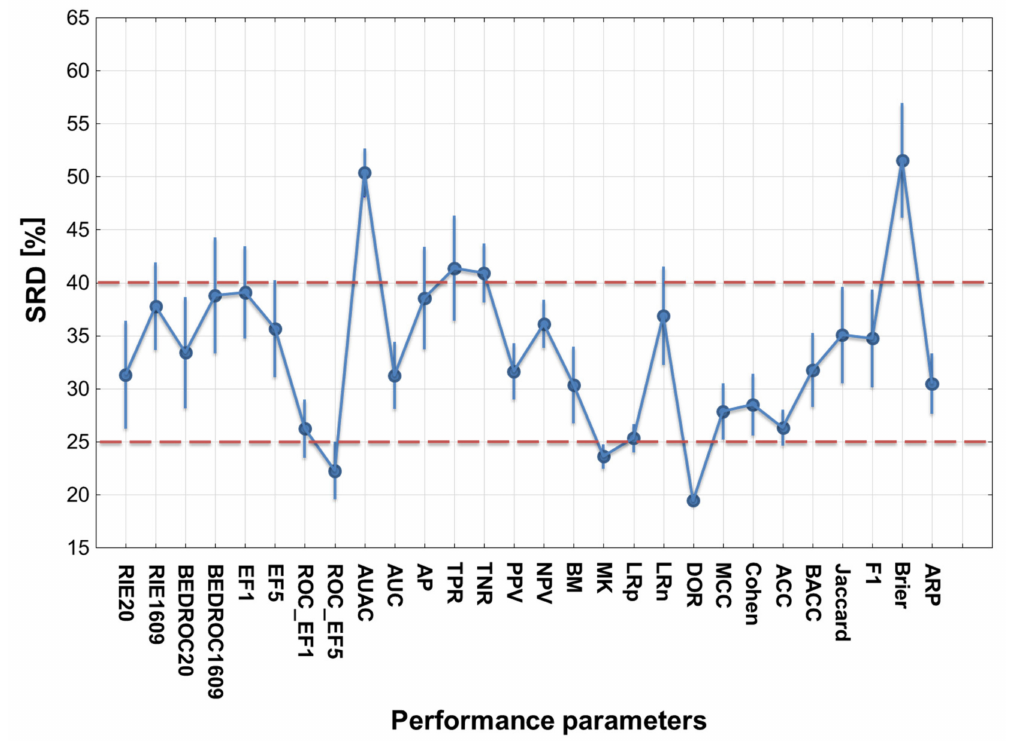
Figure 5. ANOVA result of the performance parameters based on the SRD (%) values. Arbitrary dotted lines denote the classification of the performance parameters into good, medium and not recommended